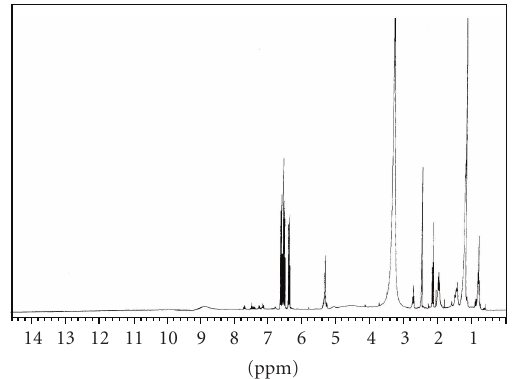
Figure 7: 1 H NMR spectrum of natural rubber-g- o -aminophenol (NR-g- o